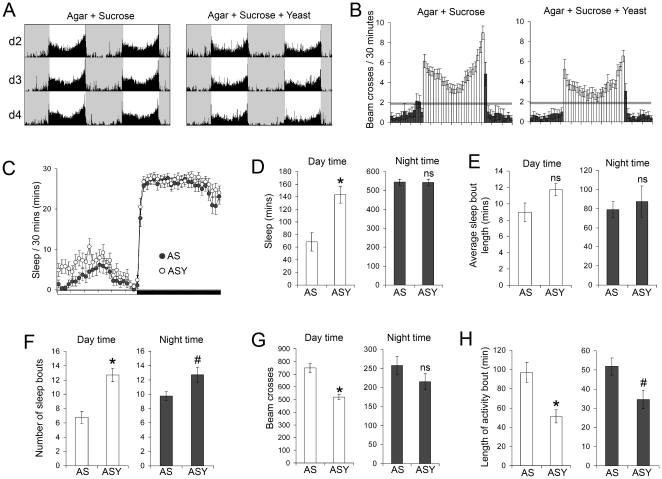
Effects of dietary yeast extract on sleep-wake behaviour of female Drosophila.(Legend as for figure 1). *P<0.01; #P<0.05; n = 48 flies for each diet, data pooled from two independent trials.